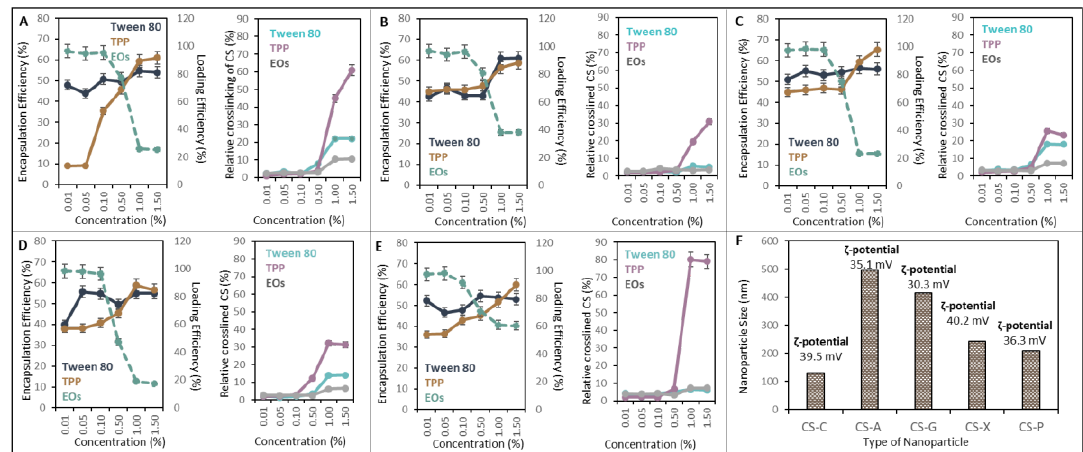
Figure 1. The optimization of NCap preparation: ( A ) C-C, ( B ) C-A, ( C ) C-G, ( D ) C-X and ( E ) C-P NCaps. The tested concentrations of Tween 80, tripolyphosphate (TPP) and essential oils (EOs) were in the range from 0.01 to 1.50% of the total volume of the reaction mixture. Figures on the left: encapsulation efficiency is calculated as the total concentration of EOs related to encapsulated concentration EOs in NCaps. LE (secondary axe, dashed line) is calculated as a total concentration of EOs related to NCap weight. On the right: relative crosslinking of C under various TPP, Tween 80 and EOs concentrations. ( F ) Size and ζ -potential of the prepared Ncaps: Results are expressed as an average of three measurements n = 3.